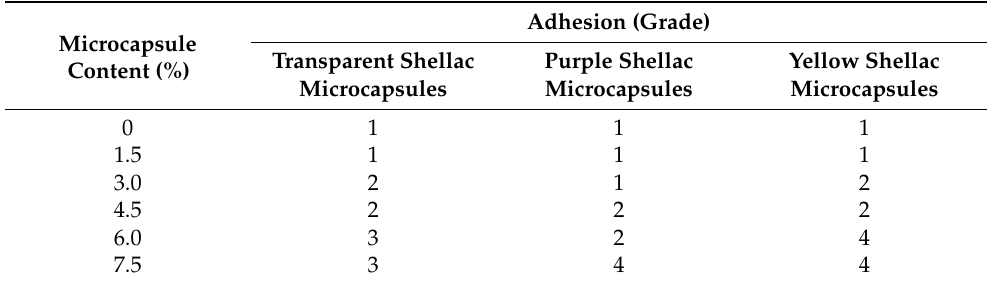
Table 7. The adhesion of the coating on Beli wood with the content of different shellac core microcap- sules in the coating.